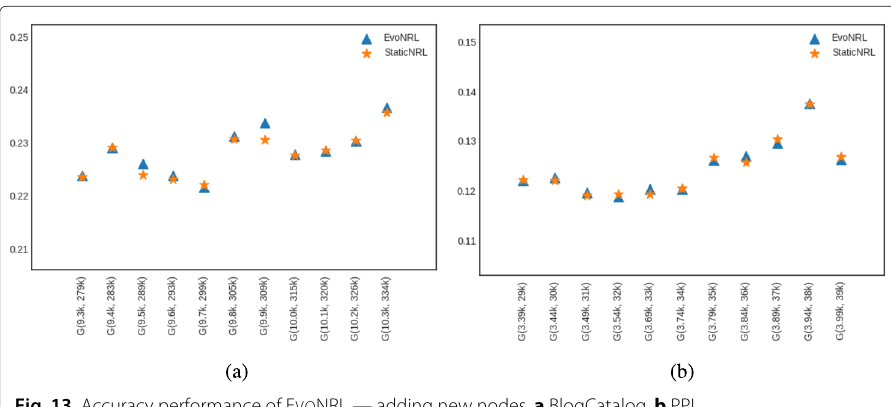
Fig. 13 Accuracy performance of E VO NRL — adding new nodes. a BlogCatalog, b